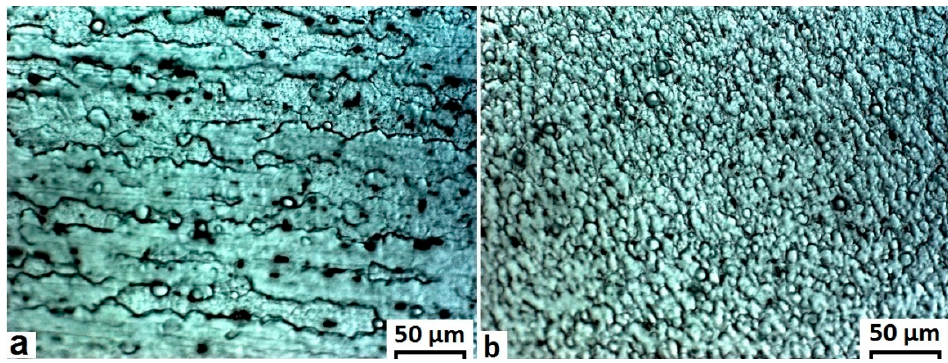
Figure 5. A comparison between ( a ) the Base Metal (B.M) and ( b ) the Stir Zone (S.Z) for the A6082-T6 weld cross-section (processed by etchant C).